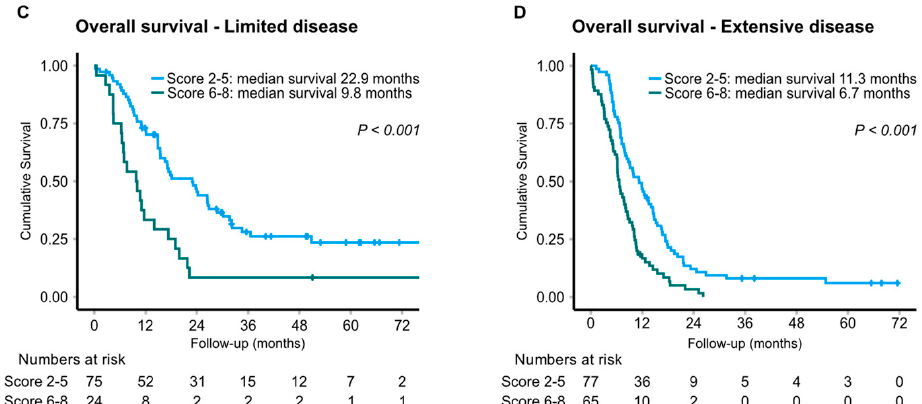
Figure 3. Kaplan–Meier analysis of survival by combined biomarker score of MR-proADM and ST2. One-year survival ( A ) and overall survival for all patients ( B ) and by stage; limited ( C ) and extensive ( D ) disease.